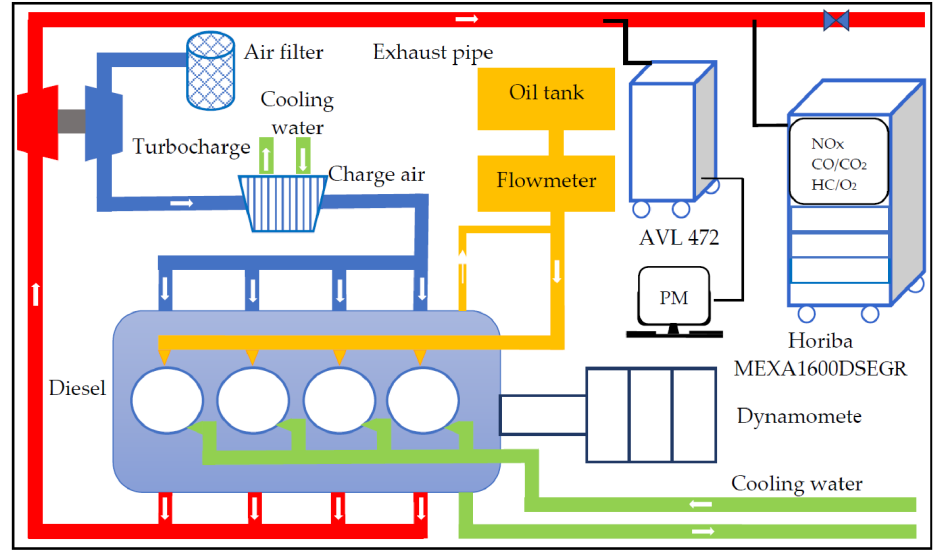
Figure 1. Layout diagram of the diesel engine bench emission test equipment.